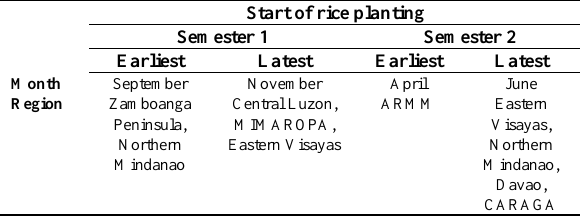
Table 3. Regions with the earliest and latest start of rice planting by semester.